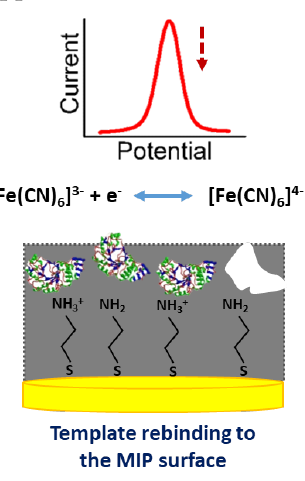
Randle’s equivalent circuit, Table S1: Fitting parameters using the Randles circuit, Figure S2: opti- using the Randles circuit, Figure S2: optimization of the MIP film thickness, Table S2: methodologies mization of the MIP film thickness, Table S2: methodologies reported in literature for α -amylase reported in literature for α -amylase detection in saliva, Figure S3: reusability, Figure S4: selectivity detection in saliva, Figure S3: reusability, Figure S4: selectivity and application of the biosensor, Table S3: determination of α -amylase in human